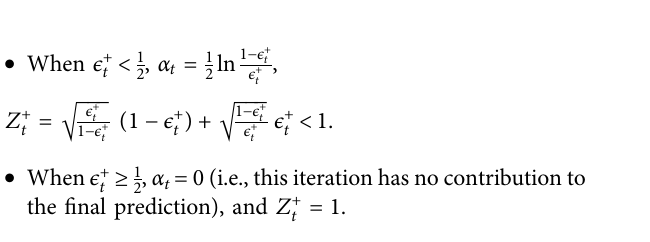
Frontiers in Big Data |